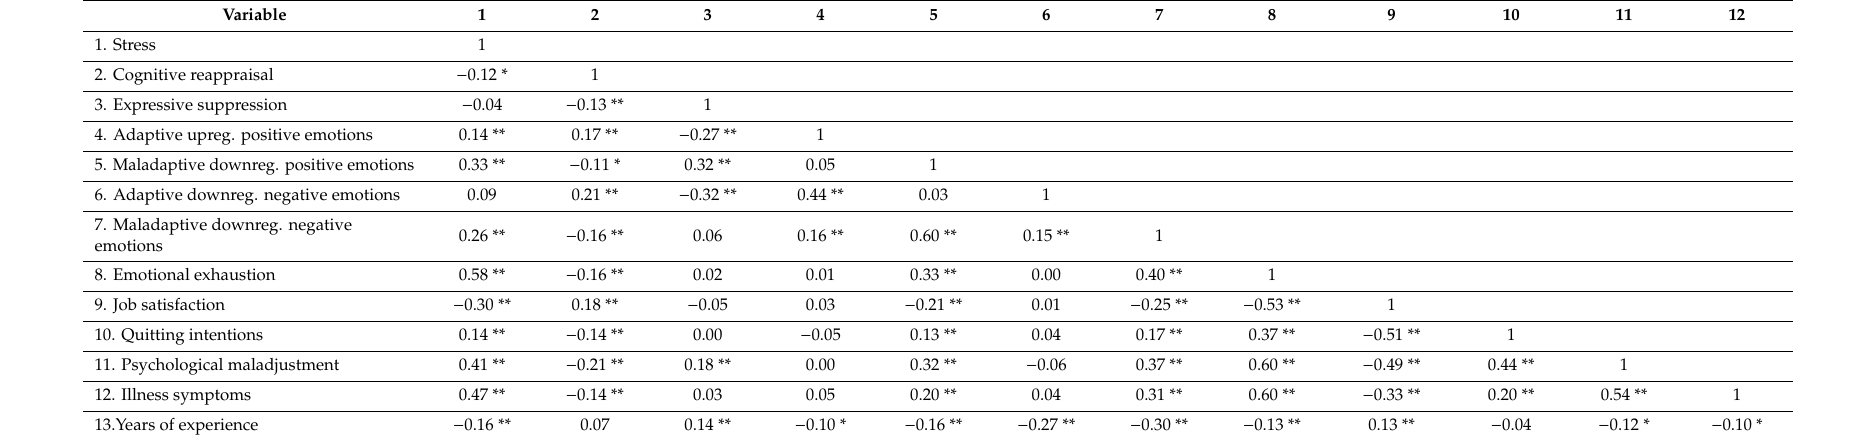
Table 2. Zero-Order Correlations among Study Variables.